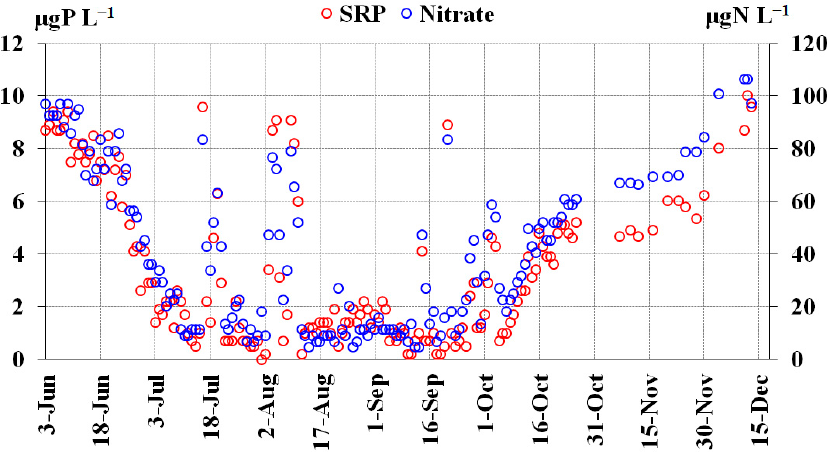
Figure 3. Nitrate (NO 3 − ) and phosphate (SRP) concentrations in the littoral zone of Lake Baikal in 2020.